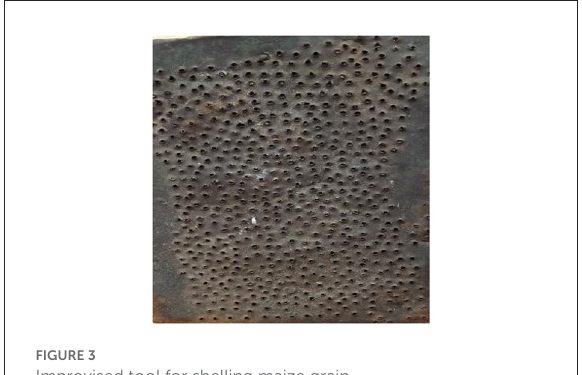
FIGURE4 Drying of shelled grain on a bare floor in Brong-Ahafo region.